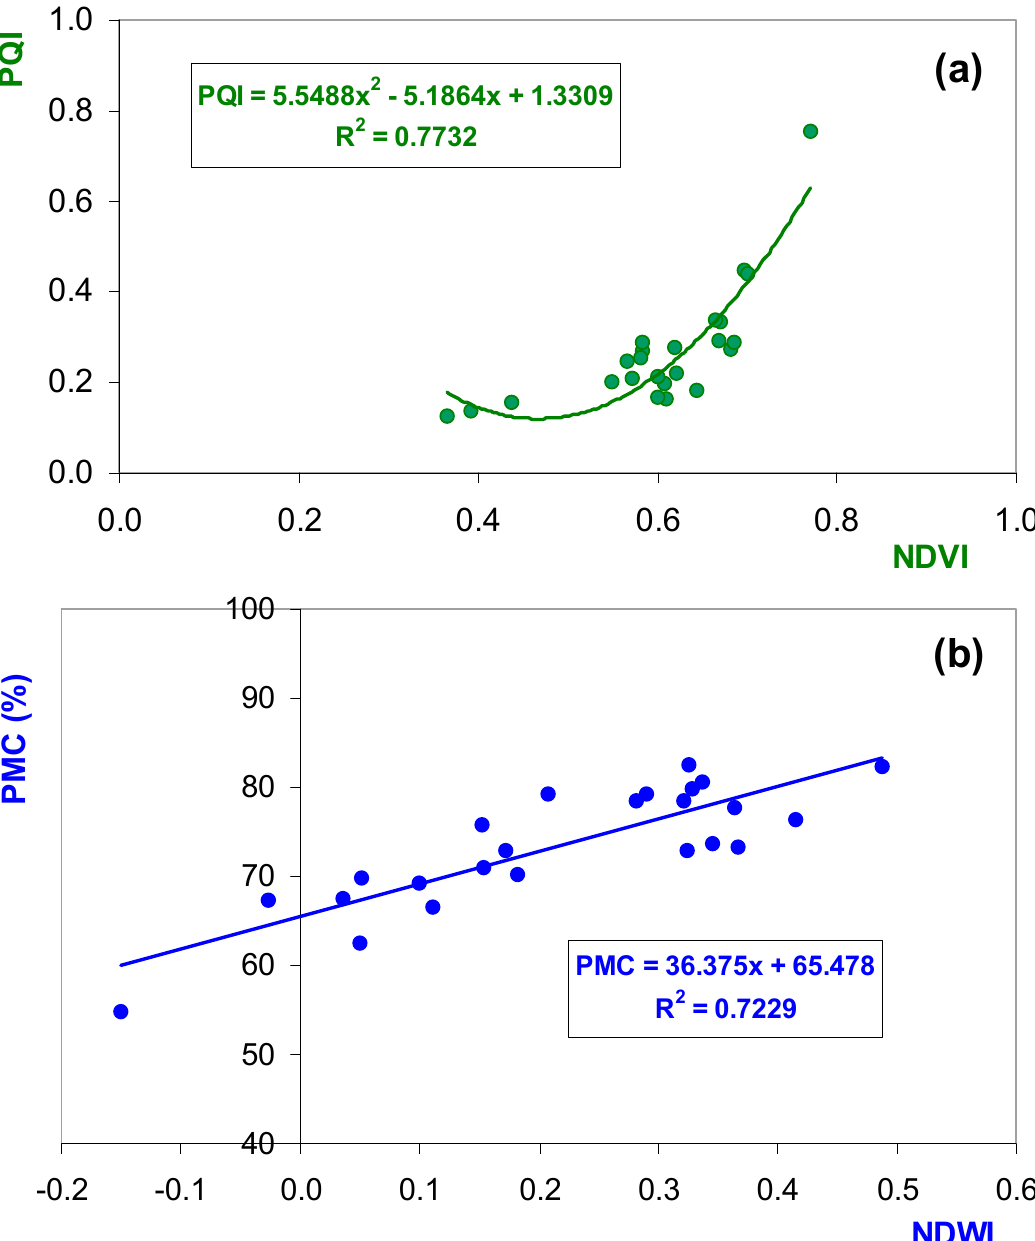
Figure 6. Relationship between ( a ) the PQI and the remote sensing NDVI (NDVI RS ); ( b ) PMC and the remote sensing NDWI (NDWI RS ) over sampling times (between January and May 2019) and locations (8 experimental fields). Data are the average values of sampling pixels in each time and site location.